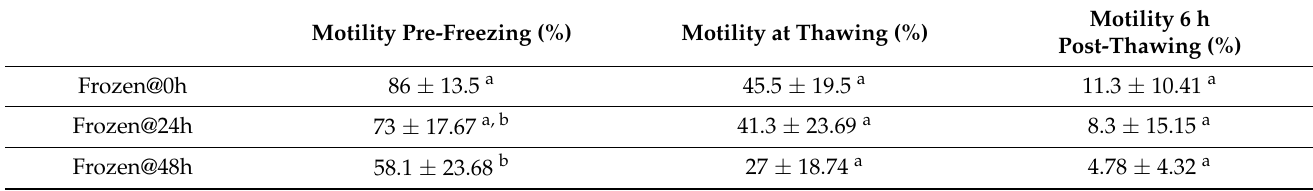
Table 2. Subjective motility of ejaculated canine spermatozoa after standard freezing (Frozen@0h) or freezing at different times of storage in a transport box (Frozen@24h and Frozen@48h). Motility Pre-Freezing (%)